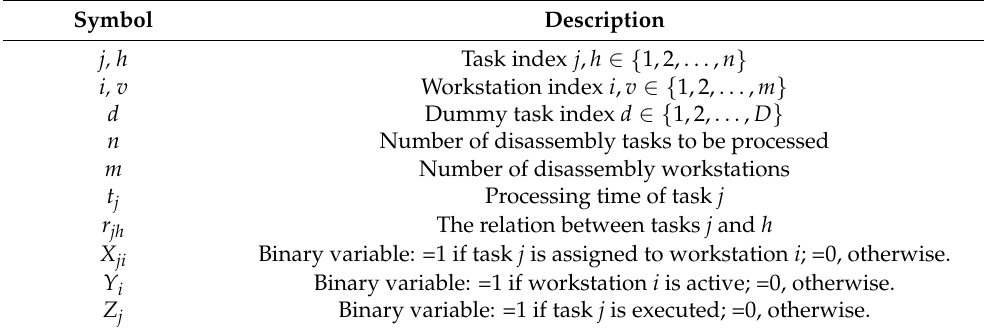
Table 1. Mathematical